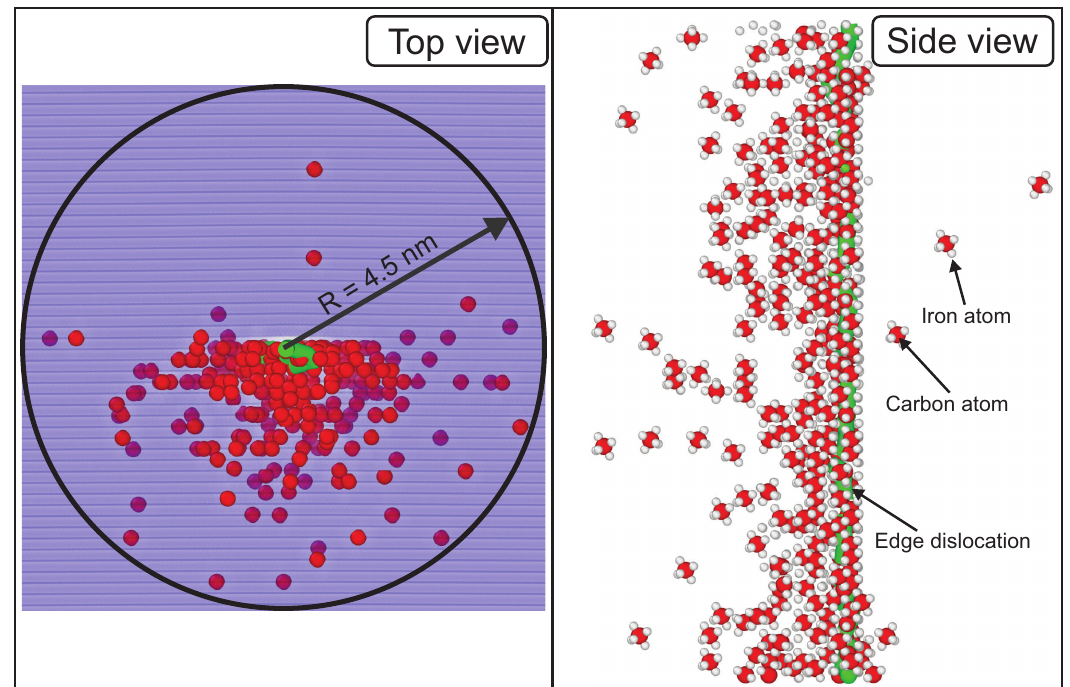
Figure 11. Snapshots showing the Carbon Cottrell atmosphere for the system equilibrated by MD simulations. ( Left ) Top view of the distribution of carbon atoms (red) in a radius of 4.5 nm from the edge dislocation, bcc iron is shown in blue. ( Right ) Side view where only carbon and disordered iron atoms (white) along the edge dislocation are